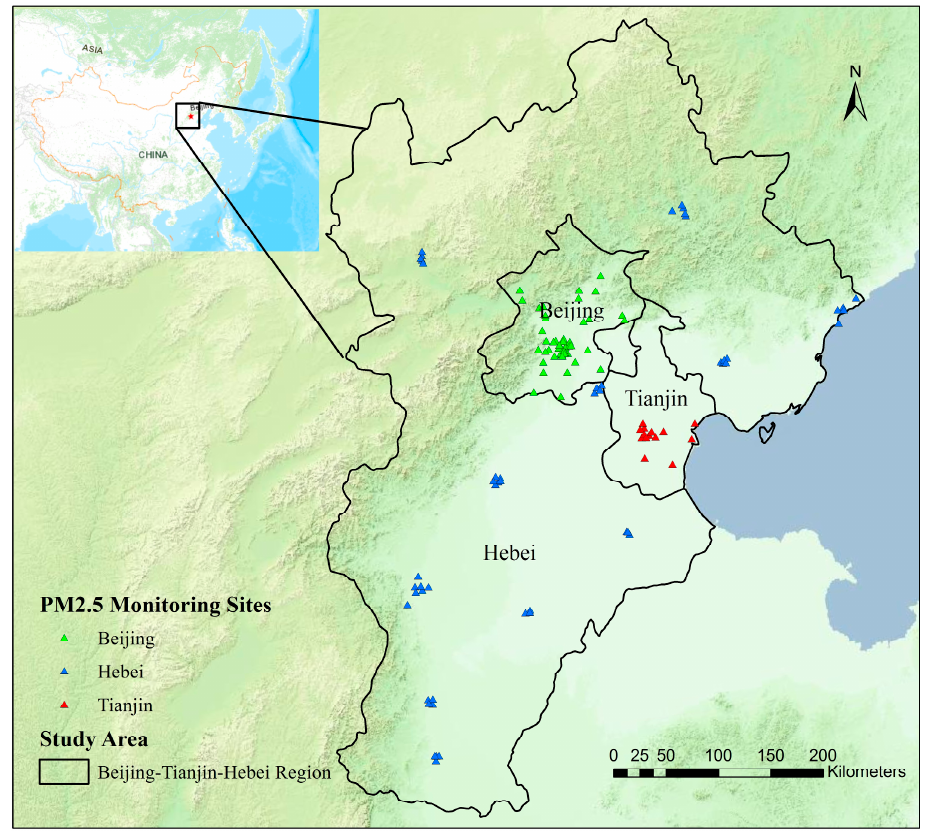
Figure 1. Study area and locations of PM 2.5 monitoring stations.